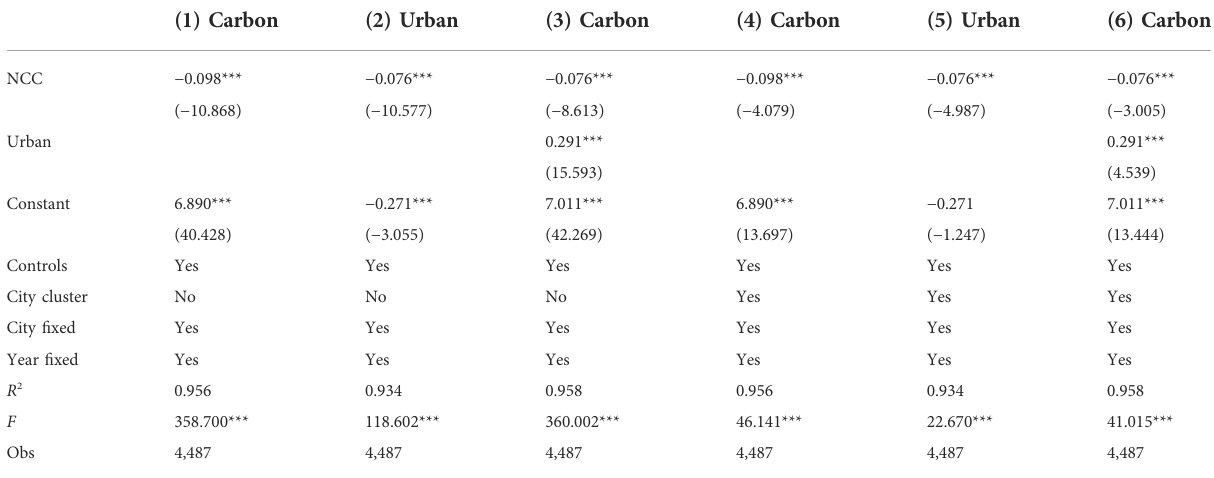
TABLE 5 Mechanism analysis based on urbanisation.